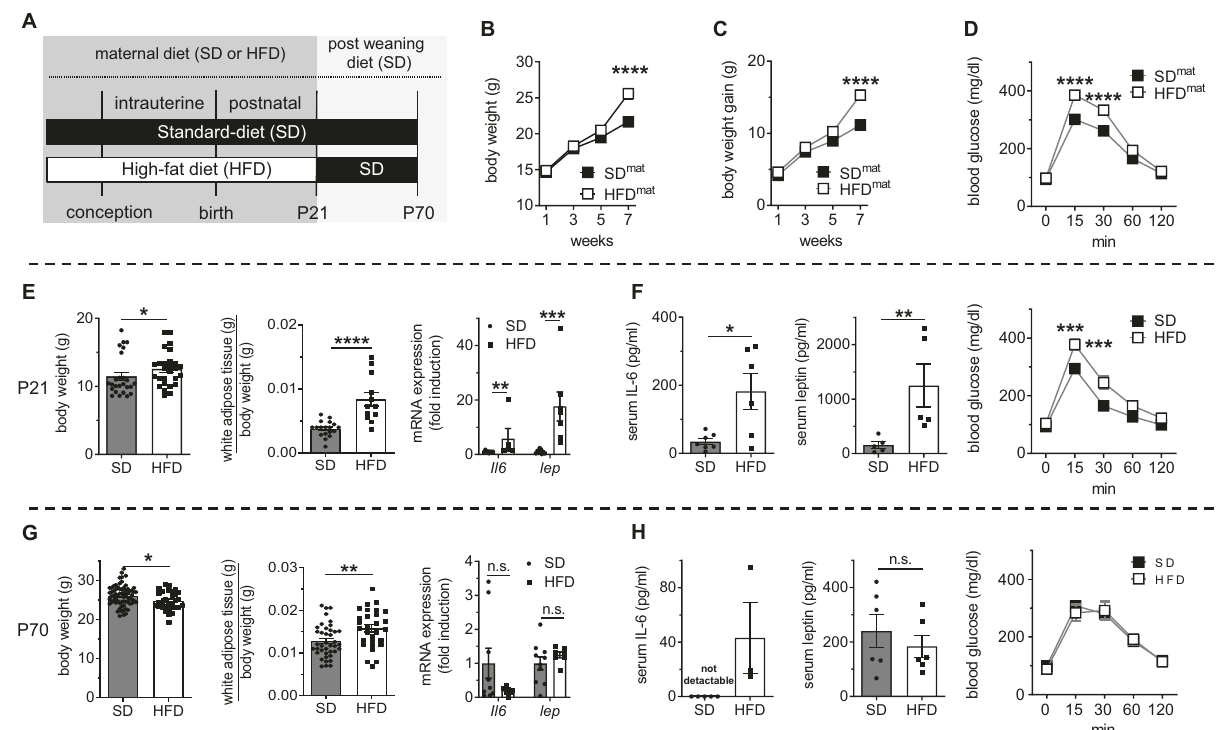
Fig. 1 A maternal prenatal and perinatal high-fat diet (HFD) and metabolic disorder induce transient early-onset obesity, elevated adipocytokine levels, and impaired glucose tolerance in offspring. A Animal model of metabolic programming. Female mice were fed a HFD for 7 weeks prior to mating; control mice received a standard diet (SD). The dams remained on their respective diets throughout gestation and lactation. The offspring of both groups were weaned at postnatal day 21 (P21) and fed SD until P70. B – D Body weight ( B ), body weight gain ( C ), and intraperitoneal glucose tolerance test (ipGTT) results ( D ) of dams prior to mating. E The body weight, ratio of epigonadal white adipose tissue (WAT) relative to body weight and mRNA expression of Il6 (interleukin-6) and Lep (leptin) in the WAT of offspring at P21 using qRT-PCR; HFD relative to SD. F Serum IL-6 and leptin concentrations in the offspring were assessed by ELISA at P21; offspring were subjected to the ipGTT. G The body weight, ratio of WAT relative to the body weight and expression of Il6 and Lep in the WAT of offspring at P70 using qRT-PCR; HFD relative to SD. H Serum IL-6 and leptin concentrations in the offspring at P70 using ELISA. Offspring were subjected to the ipGTT at P70. Data are shown as mean ± standard error of the mean B : SD n = 32, HFD n = 40; C SD n = 32, HFD n = 40; D SD n = 36, HFD n = 49; E SD n = 9 – 25, HFD n = 7 – 27; F SD n = 5 – 30, HFD n = 5 – 7; G SD n = 10 – 68, HFD n = 7 – 31; H SD n = 6 – 21, HFD n = 3 – 7. Statistical analyses were performed using the two-sided Mann – Whitney test, two-sided Student ’ s t test or two-way ANOVA followed by the Bonferroni post-test; * P < 0.05; ** P < 0.01; *** P < 0.001; **** P < 0.0001. Gray = standard diet; white = high-fat diet. A detailed list of sample sizes and P value per graph is provided in the Supplemental Material. Source data are provided as a Source Data fi le.